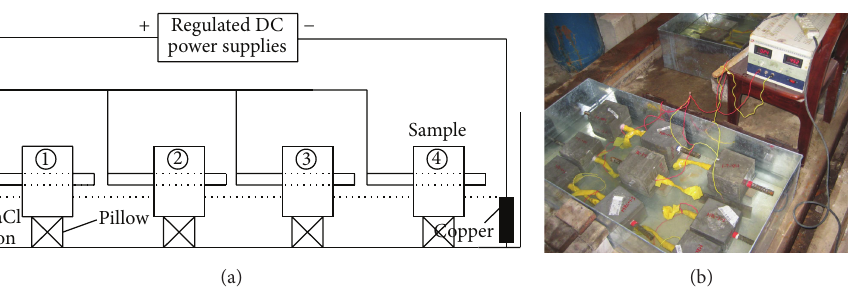
Figure 2: Parallel circuits used to accelerate the corrosion of the rebars.